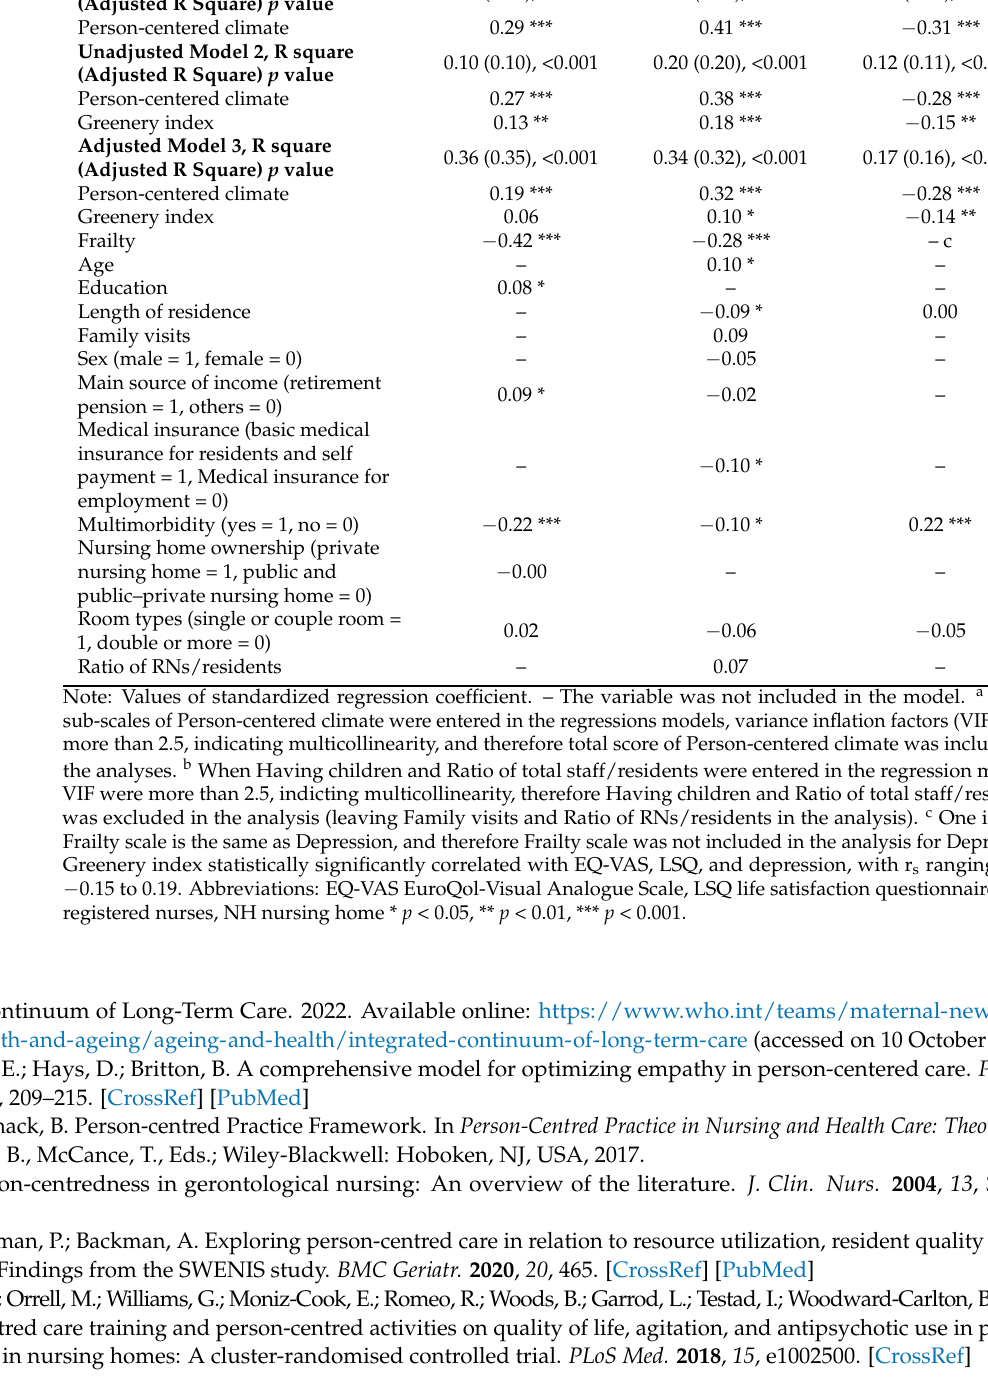
Table A1. Linear regression analyses with well-being as dependent variable and person-centered climate and greenery (with Greenery Index) as independent variables (Model 1–2), adjusted for personal characteristics and NH characteristics (Model 3) a,b ( n = 470).